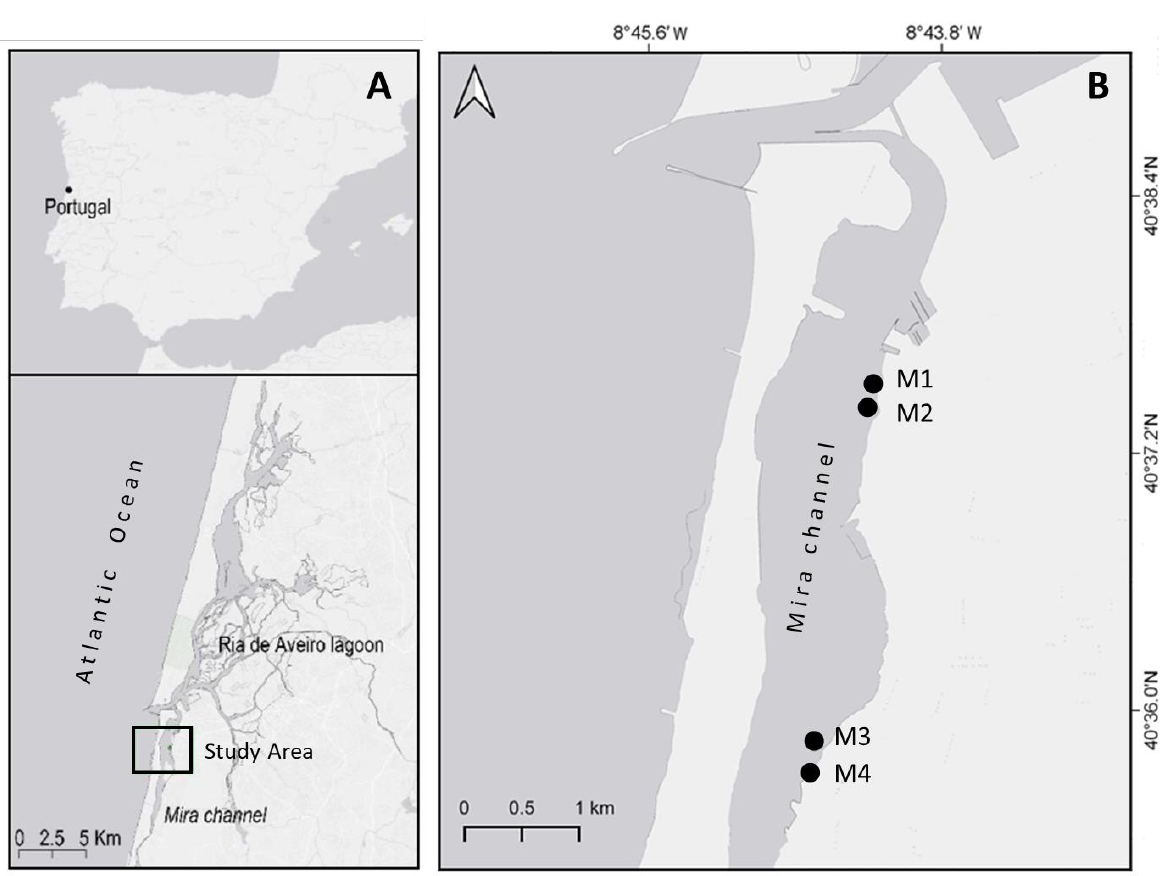
Figure 1. Study area ( A ) and location of the four studied Z. noltei meadows (M1-M4) in the Mira channel, Ria de Aveiro ( B ).